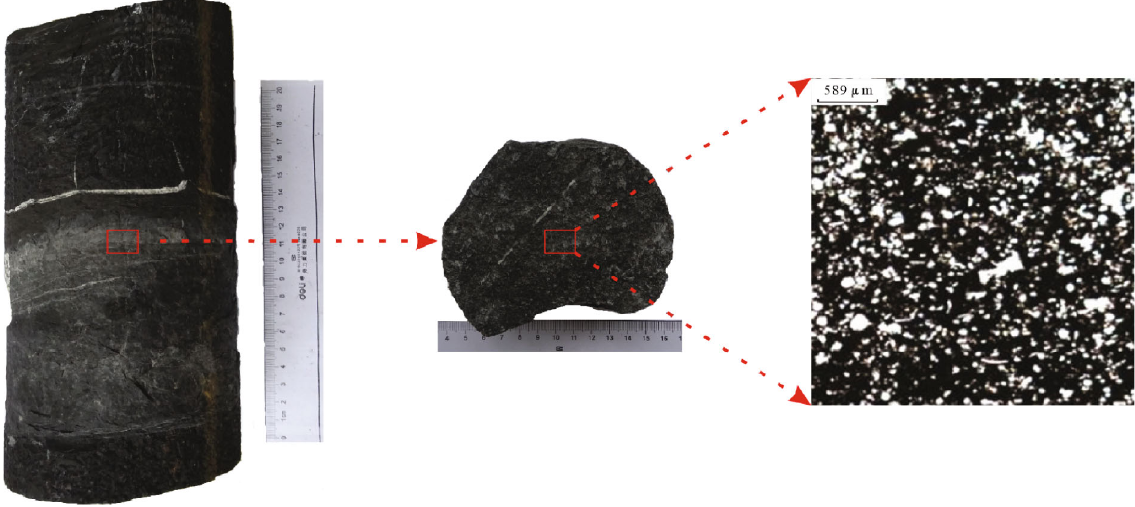
Figure 9: Spatial distribution of mineral